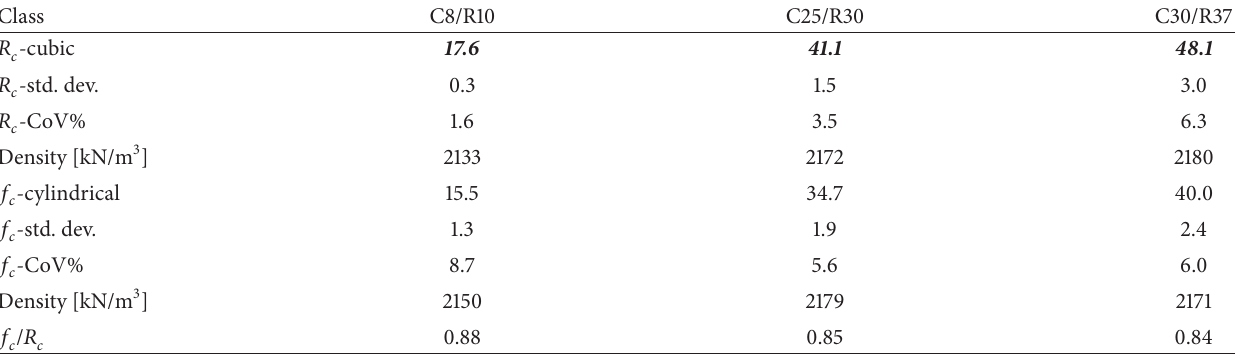
Table 1: Main data of the concrete classes.